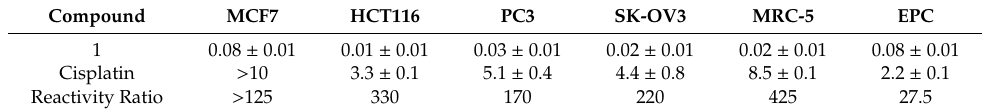
Table 1. In vitro cytotoxic activity of platinum complex 1 against several cell lines (after 72 h of incubation; stock solutions in DMSO for complex 1 ; stock solution in H 2 O for cisplatin); values in µ M.